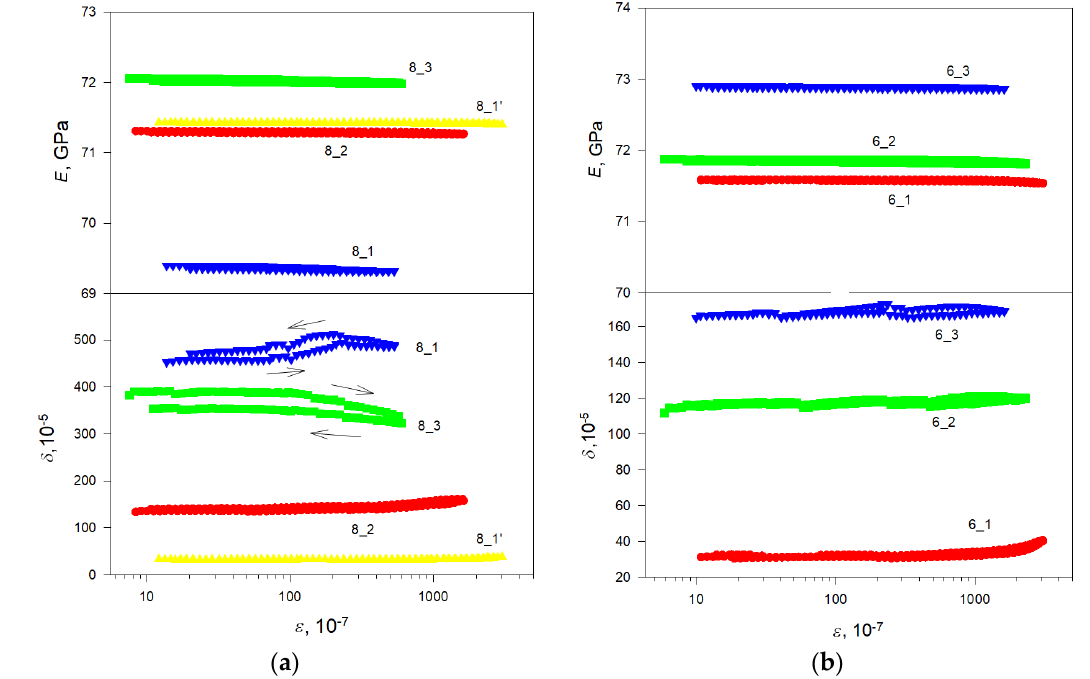
Figure 20. Dependences of the Young’s modulus E and decrement δ on the amplitude of vibrational deformation ε for Al wires of ( a ) A50 type after 10 years of service before (N8_1,2,3) and after (N8_1 ′ ) etching and ( b ) AC50 type after 20 years of service (N6_1,2,3). The measurements were taken at room temperature.